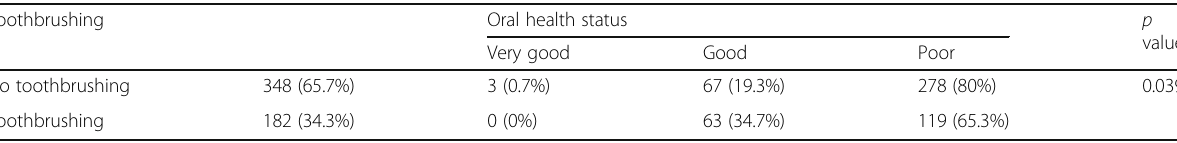
Table 6 Oral health status and toothbrushing. Toothbrushing